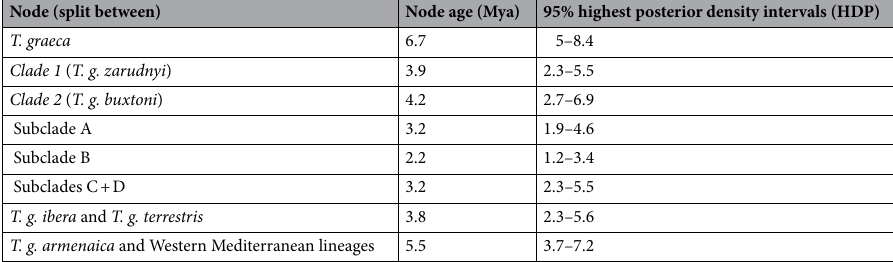
Table 3. Molecular clock estimations of Testudo graeca . See Fig. 2 for details of clades and subclades.